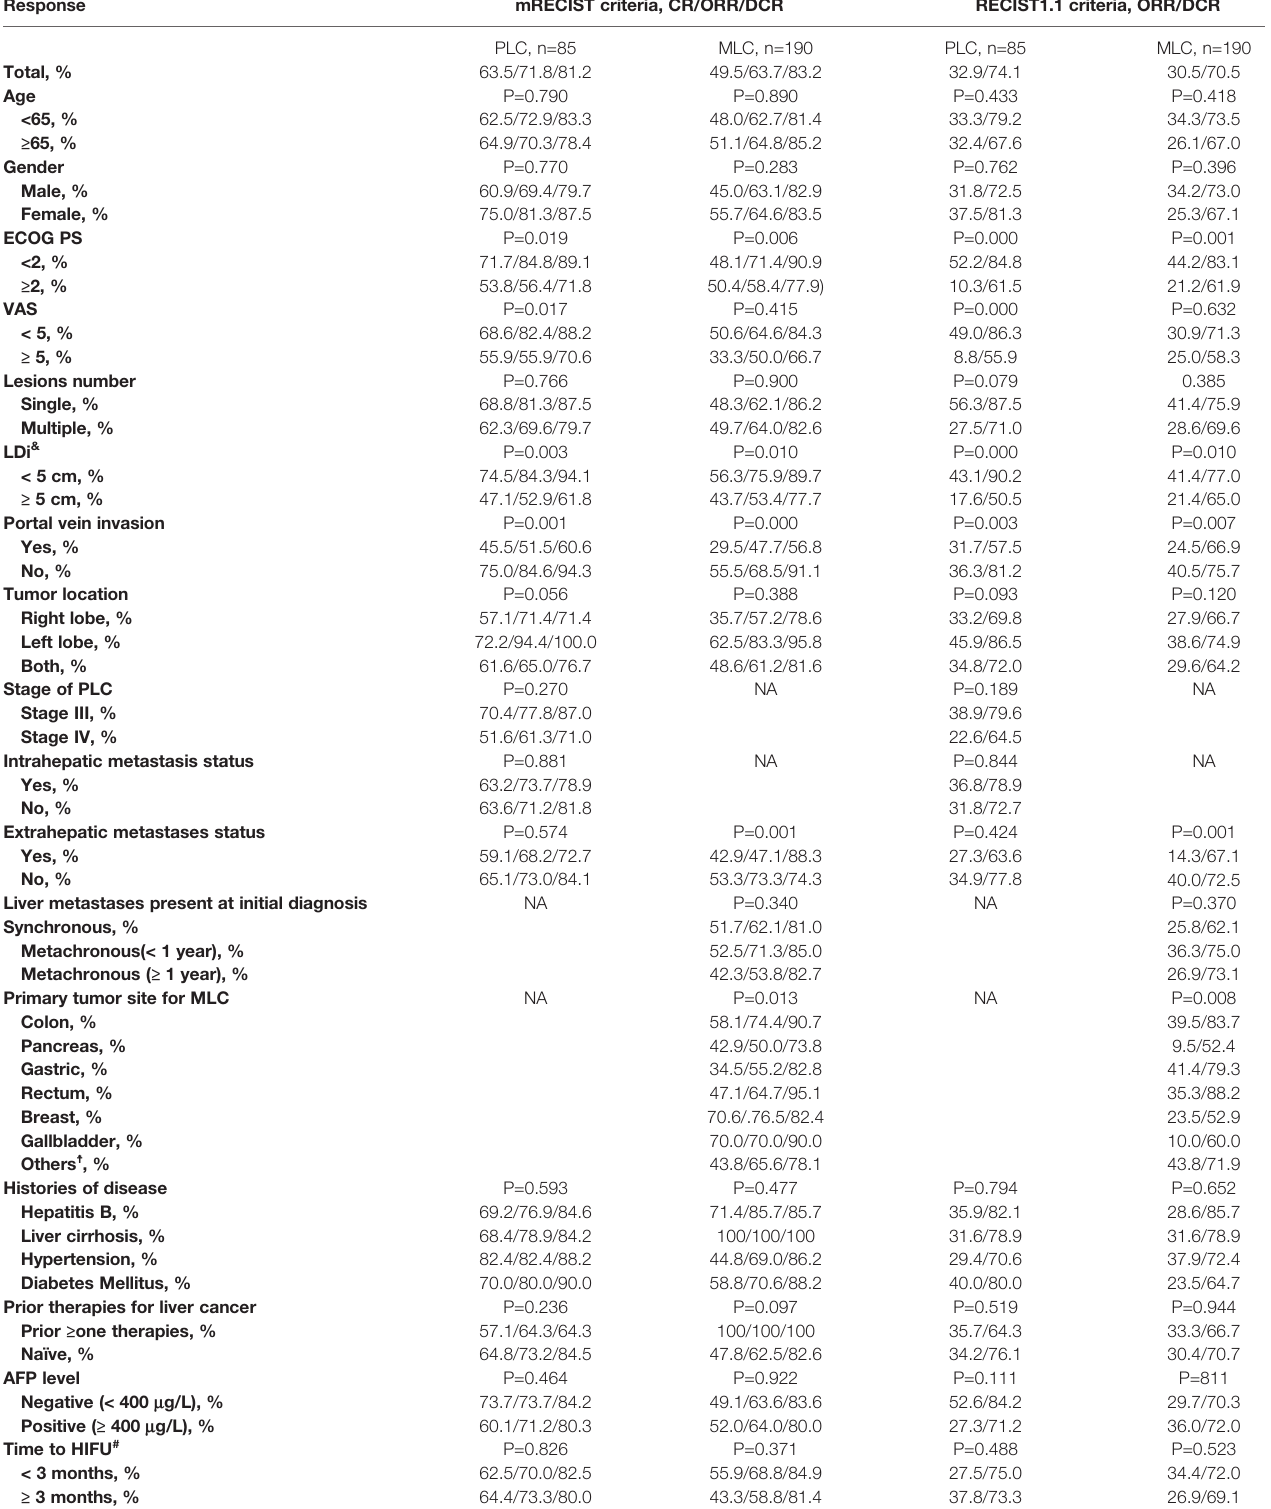
TABLE 2 | Objective response rate (ORR) and disease control rate (DCR) and subgroup